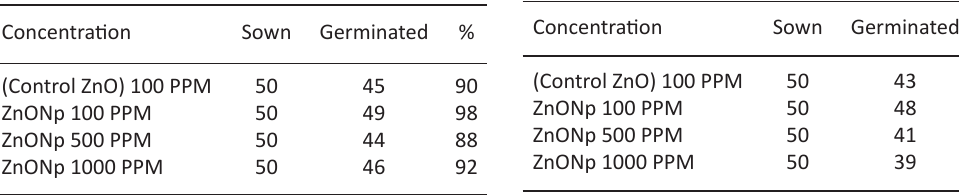
Table 5. Effect of ZnONp on Seed Germination % of Lentil ( Lens esculentum )